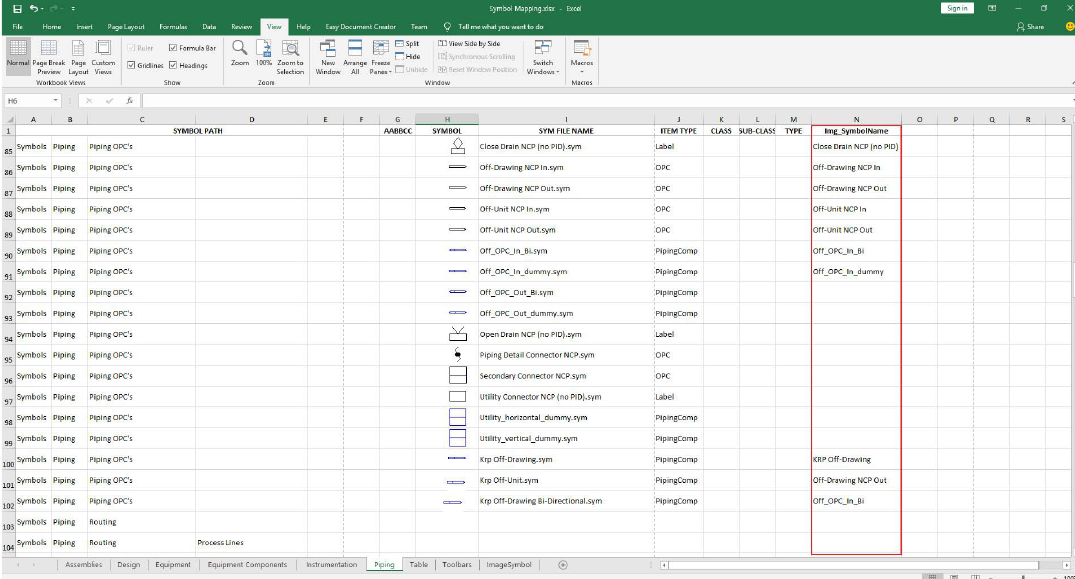
Figure 13. Mapping the symbols recognized and the symbols in SP